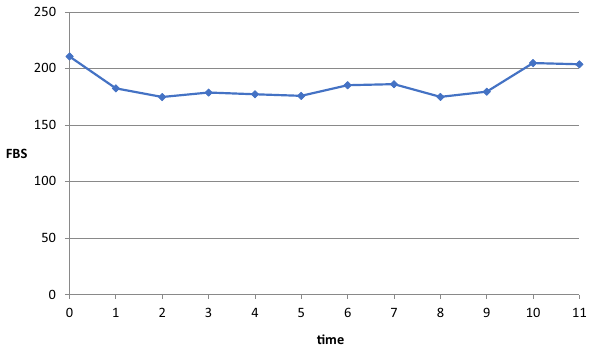
Figure 2. Fluctuation in mean FBS values over 6 months in FHRH, BD,